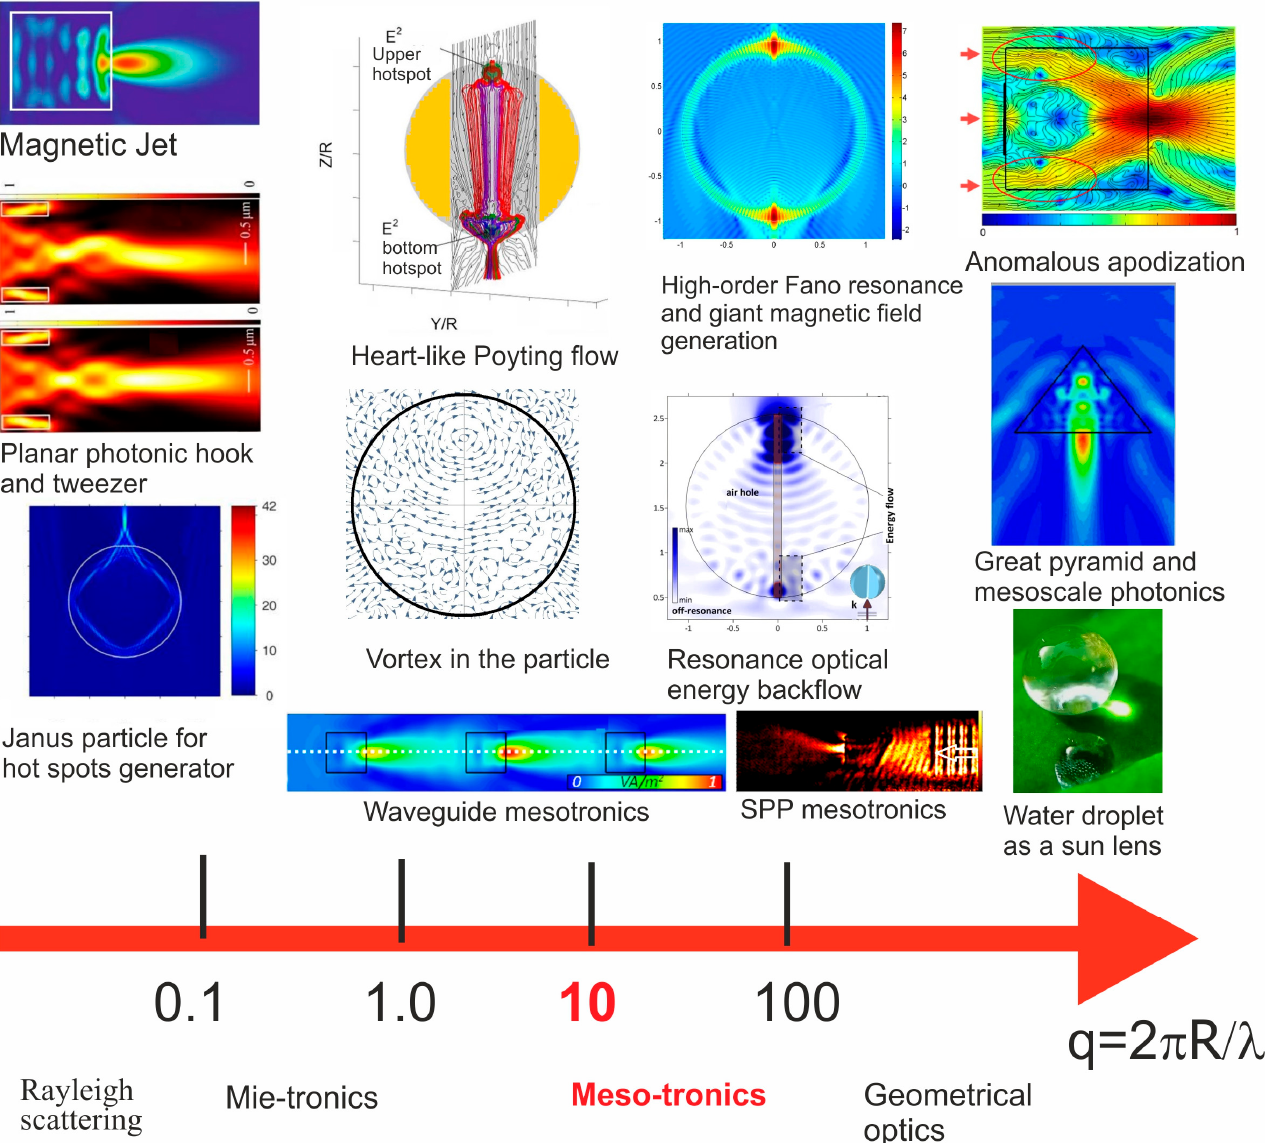
Figure 6. Schematic image for optical effects in low loss mesoscale dielectric particles [30–32,36,37].